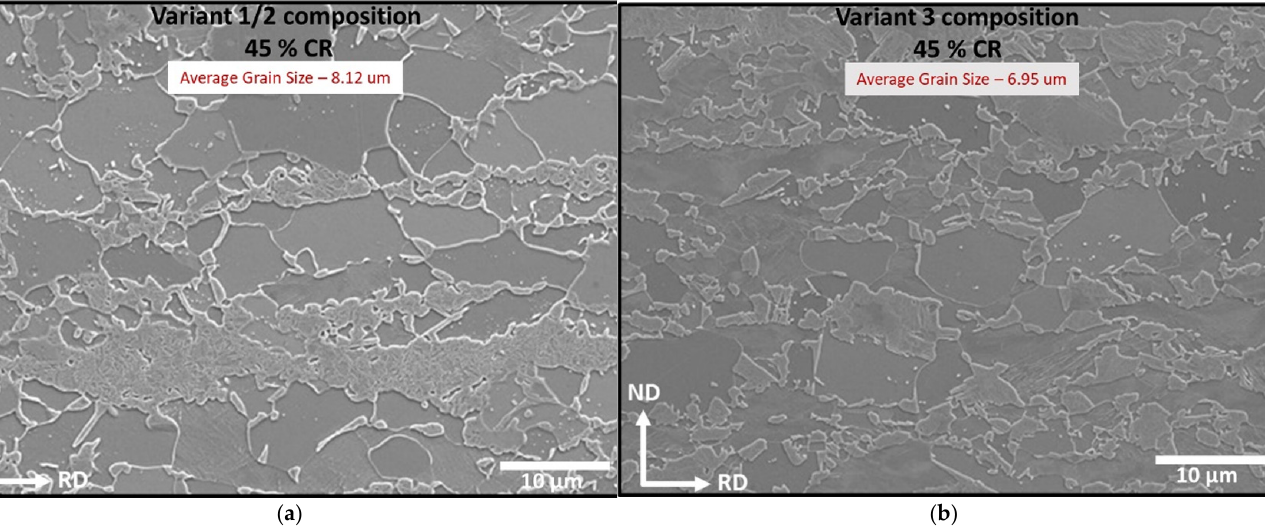
Figure 13. SEM microstructures of cold rolled 45% ( a ) Variant 1/2 composition and ( b ) Variant 3 composition steels inter-critically annealed using the standard CAPL heating rate to peak temperatures of 730 °C and 750 °C, respectively. Table 5. Comparison of the hardness values, ferrite grain sizes and martensite volume fractions with respect to cold reductions for the Variant 1/2 composition and Variant 3 composition samples annealed using the standard CAPL heating rate.